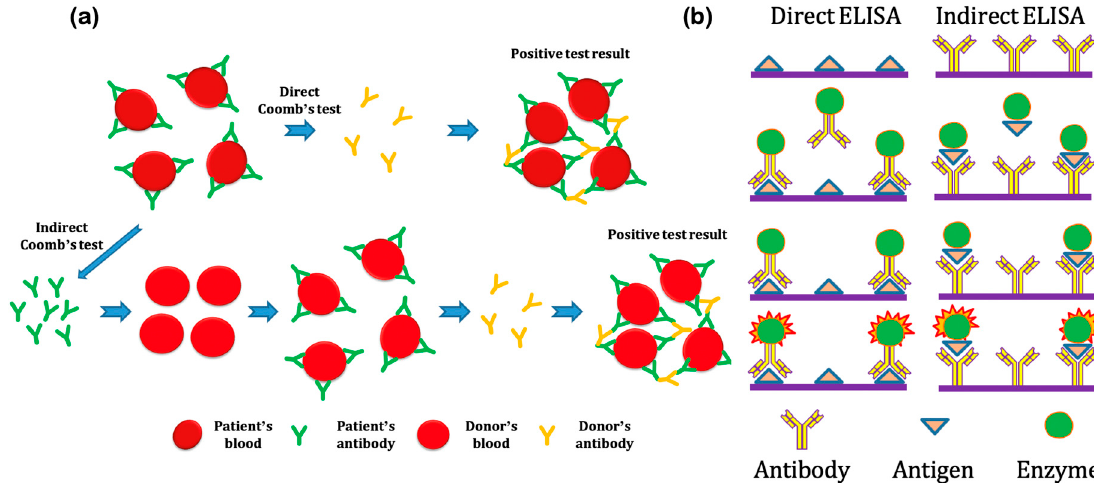
Figure 2. Current techniques to detect serological biomarkers: ( a ) Microscopic agglutination test (Coomb’s test) can be performed directly and indirectly. The direct test exposes the patient’s blood with the donor’s antibody whereas the indirect test exposes the patient’s antibody to the donor’s blood. In both cases, the positive results are associated with the formation of cell clumps; ( b ) Enzyme-linked immunosorbent assay (ELISA) can be performed directly and indirectly. The direct test binds the antigen of interest to an immobilized surface whereas the indirect test binds the antibody of interest to the immobilized surface. The positive results are associated with the color changes due to substrate and enzyme interaction.